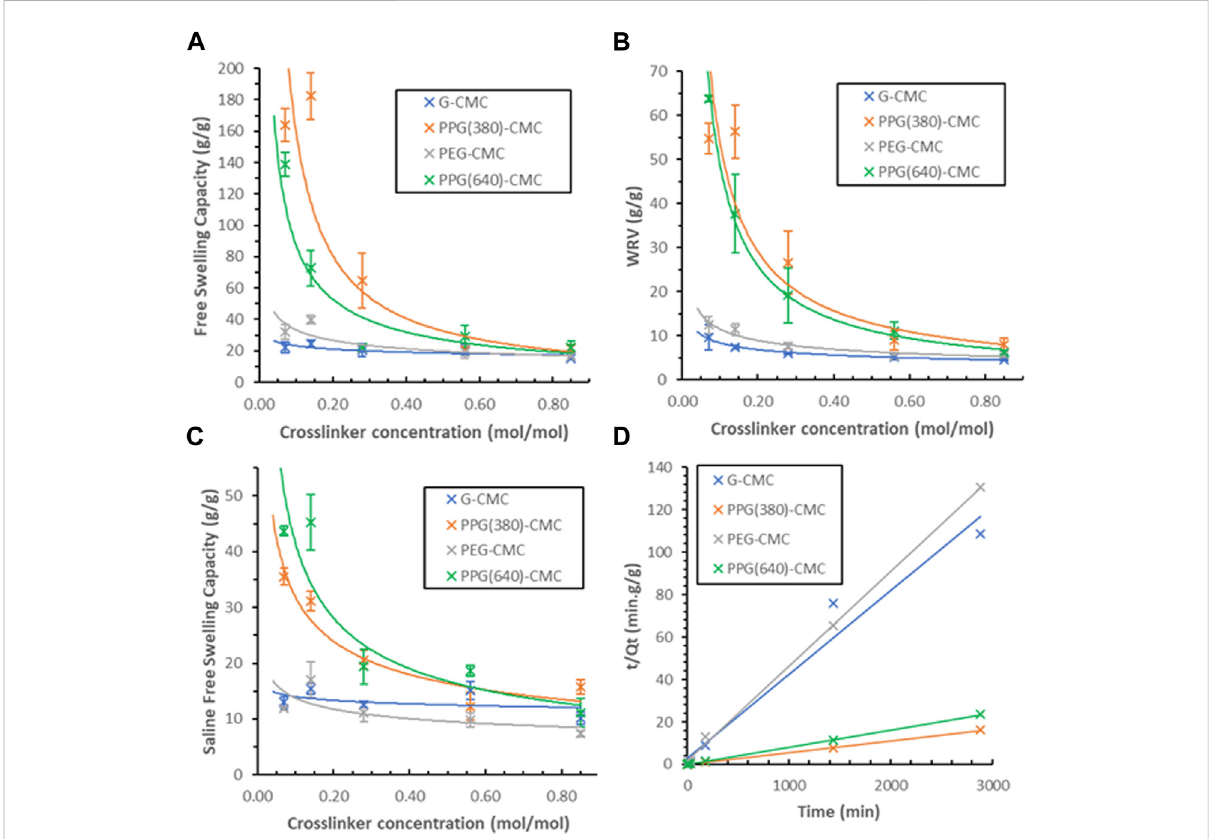
FIGURE 6 SwellingcapacityofCMC-DE fi lms; (A) EffectofthecrosslinkerconcentrationonthefreeswellingcapacityofCMCmaterialsindeionisedwater, (B) Effect of the crosslinker concentration on the water retention values for CMC hydrogels in deionised water, (C) Free swelling capacity of CMC materials in physiological saline (0.9%wt NaCl), (D) Schott ’ s model for inverse rate of swelling of each 0.07 mol/mol